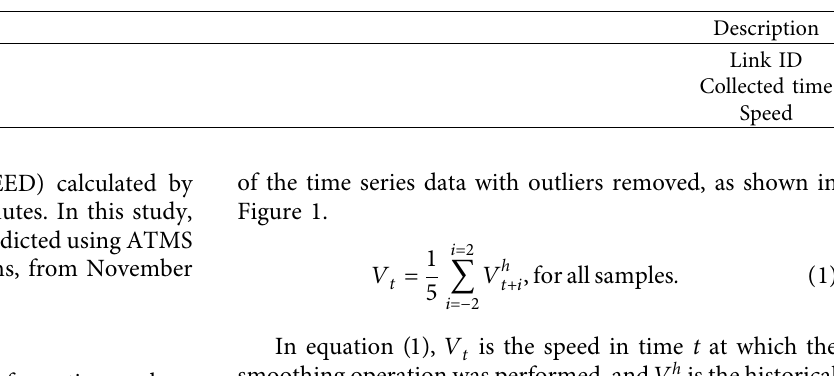
Table 2: Field items of advanced traffic management system (ATMS) data.